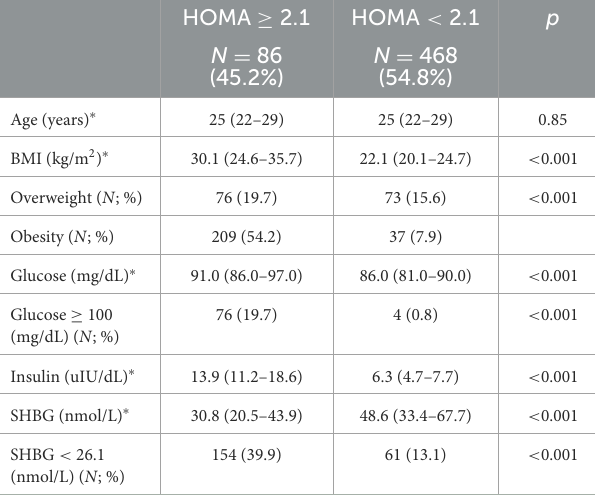
TABLE 3 Comparison between subjects with lower and higher HOMA-IR using the established cut-off value. HOMA ≥